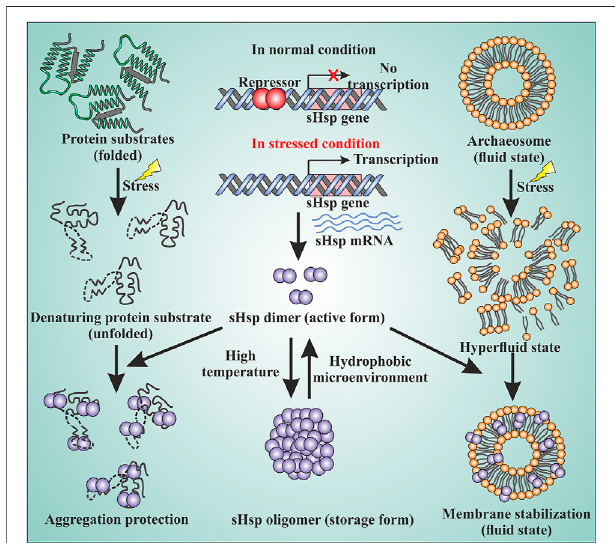
FIGURE 2 | sHsps in archaea are involved in various cellular functions. The sHsp genes are under the control of transcriptional regulators. Under normal growth condition, a repressor binds to the upstream of the genes and theexpressionofthegenesareturnedoff.Underthestressedcondition, the repressor can no longer bind to DNA and the sHsp genes are expressed. The dimer is the active form of sHsps. At high temperatures, the dimers can associate with each other and form a large oligomeric structure which is the storage form of the sHsps (middle panel). Under the stressed condition, the native proteins of the cell start to unfold. The unfolded proteins can lead to the formation of large amorphous aggregates. sHsps bind to the unfolded proteins by their hydrophobic patches and protect against stressed-induced aggregation (left panel). Stress can also lead to membrane destabilization. sHsps can bind to the membrane and thereby maintain membrane fl uidity (right panel) by stabilizing the